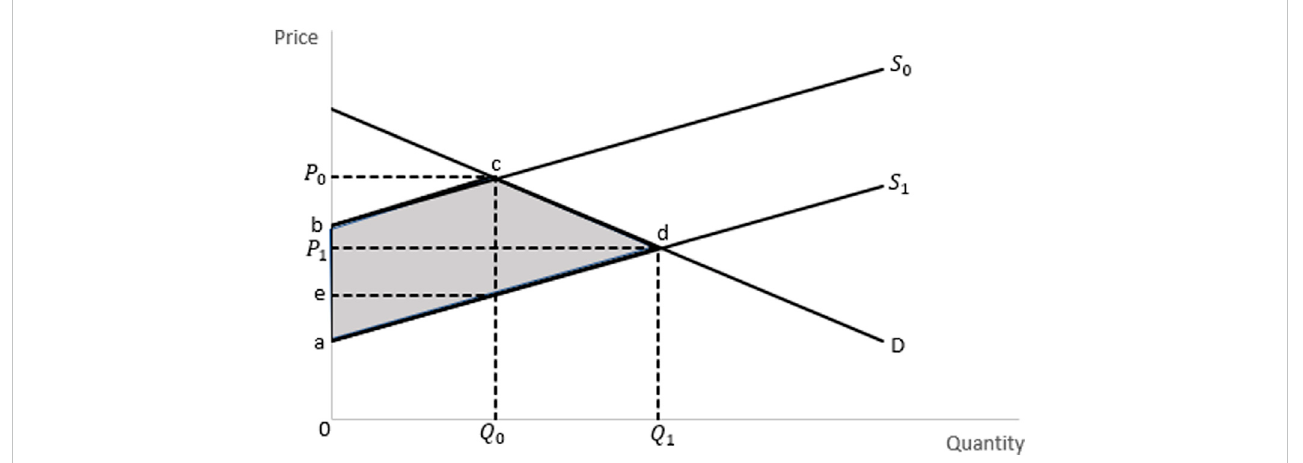
FIGURE 2 Basic economic surplus change model Note: P 0 and Q 0 are initial price and quantity, P 1 and Q 1 are fi nal price and quantity, S 0 and S 1 are initial and fi nal supply, D is demand (unchanged), and the change in total surplus is represented by shaded region